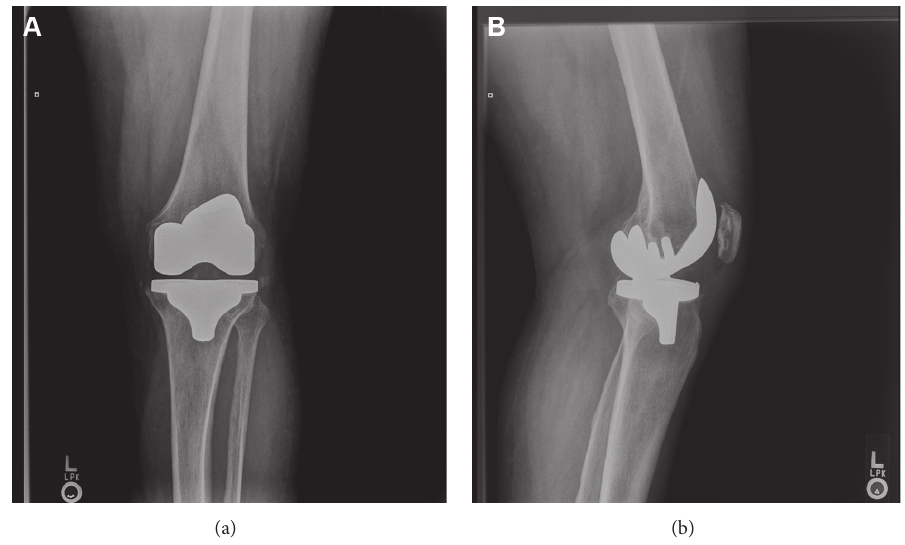
Figure 1: Anterior-posterior (a) and lateral (b) radiographs of left primary total knee arthroplasty from initial clinic presentation.